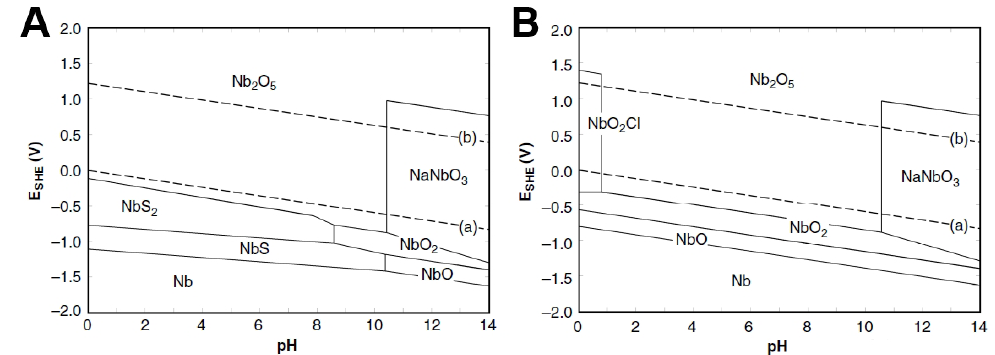
Figure 11. E-pH diagrams for Nb species in the A) Nb-Na-S-H2O system at 25°C, concentrations: niobium 10-6 mol/L, sodium 0.22 mol/L, and sulfur 0.20 mol/L; B) Nb-Na-Cl-H2O system at 25°C, concentrations: niobium 10-6 mol/L, sodium 0.16 mol/L, and chlorine 0.17 mol/L (Santandrea et al. 48